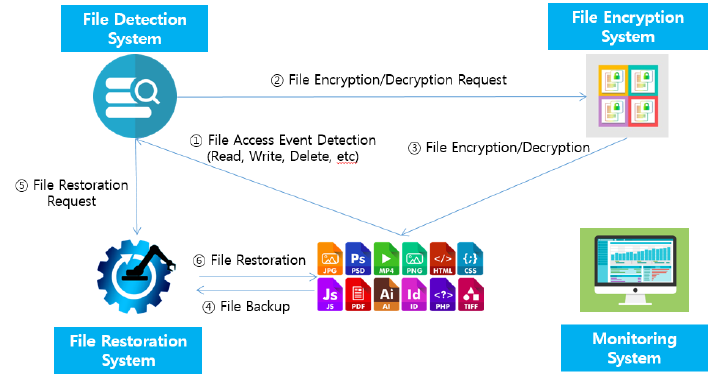
Figure 1. Architecture of the existing file encryption system.